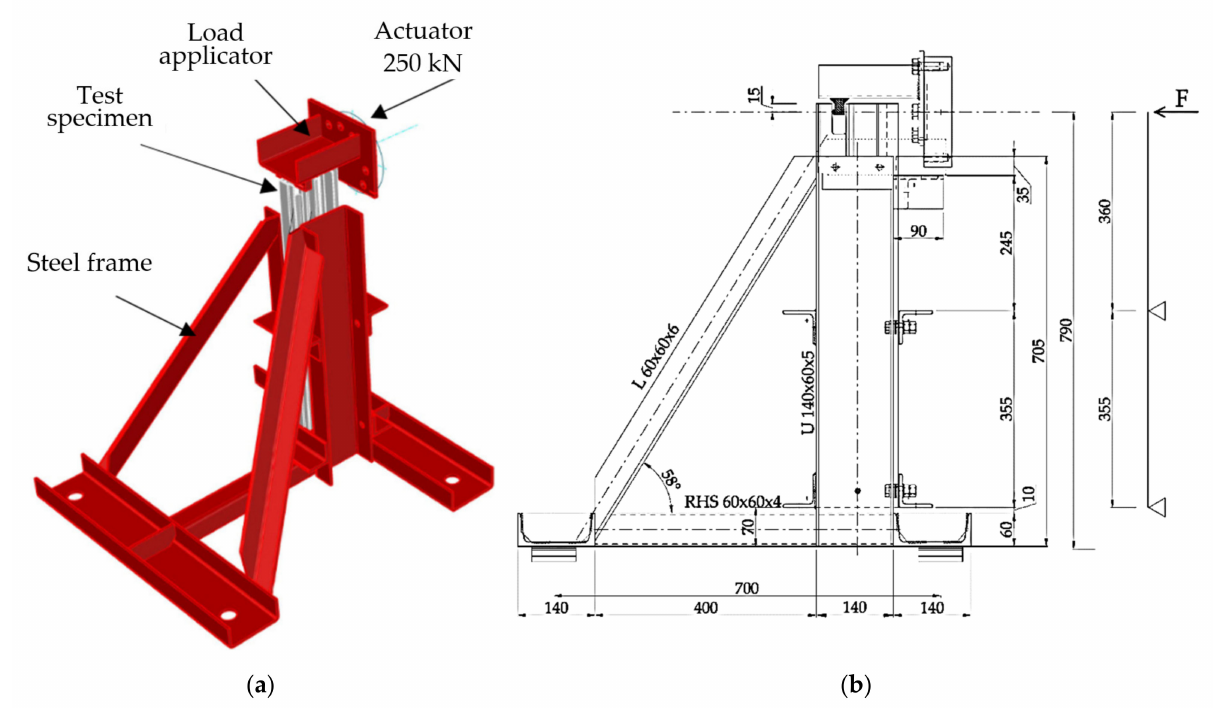
Figure 8. ( a ) Test setup; ( b ) test frame and the structural system (mm).